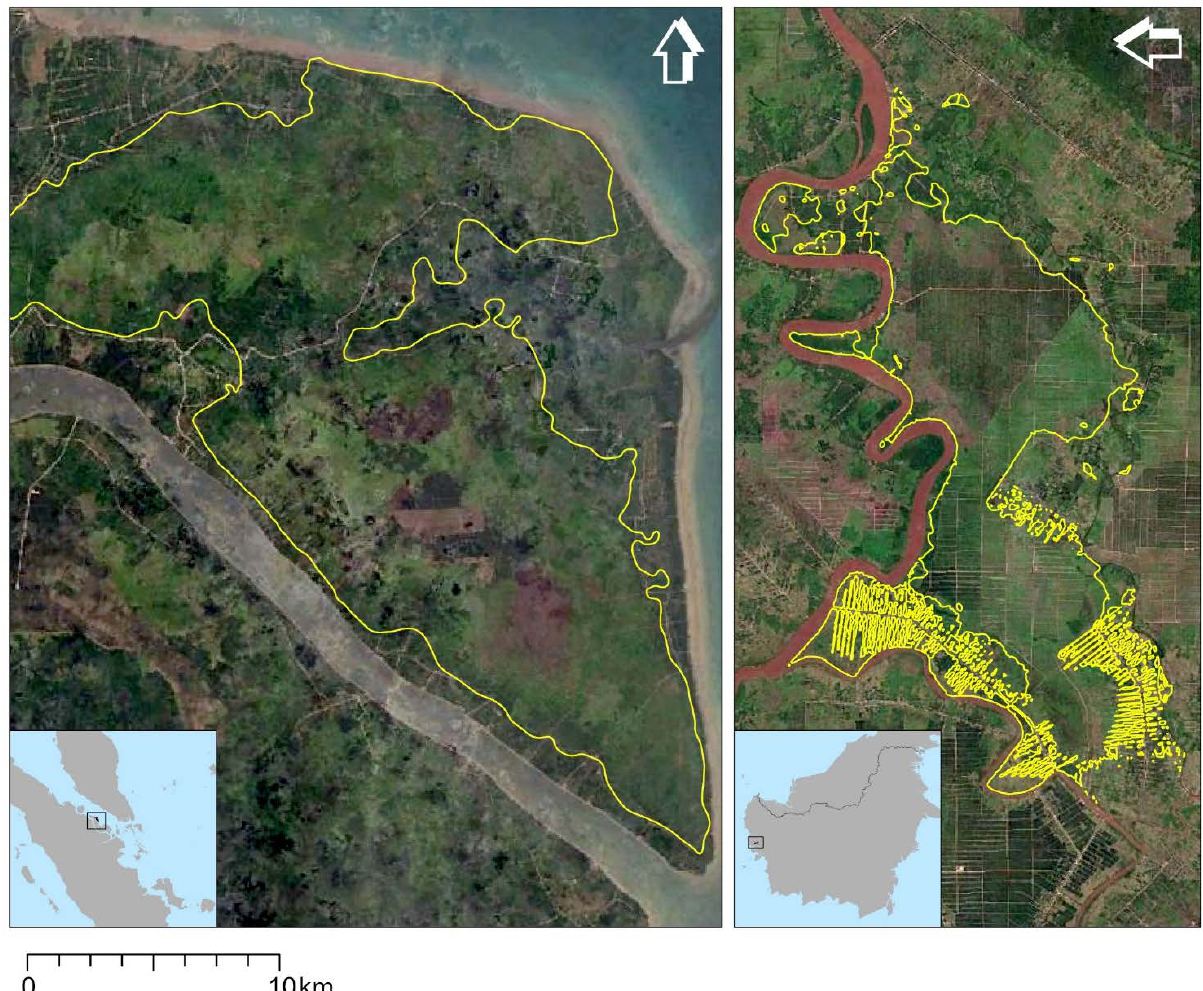
Figure 2. Extent of peat, bounded by the 0.40 m peat thickness isopach (yellow line), at the Bengkalis (left) and Kubu Raya (right) sites in Indonesia. At Kubu Raya, peat deflation following drainage and small cropping created a highly convoluted boundary. Elsewhere, the boundary is not aligned with any land use or land cover distinction visible in the satellite